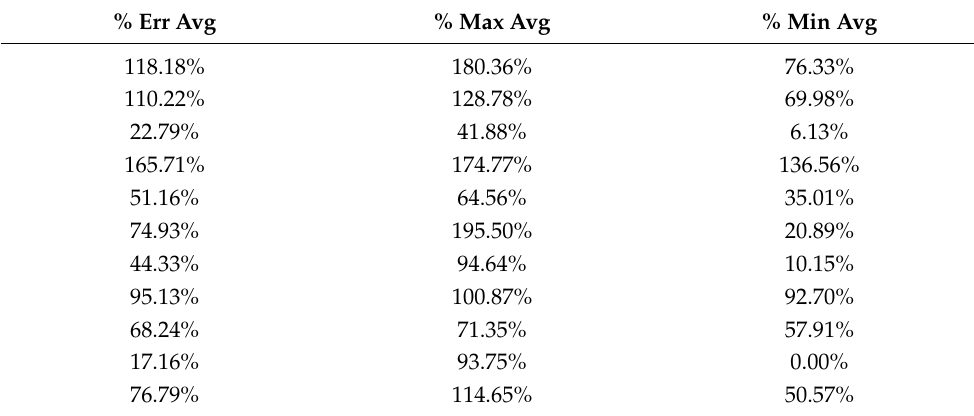
Table A121. Set 2, trials 21–30 data (average actual PR values).